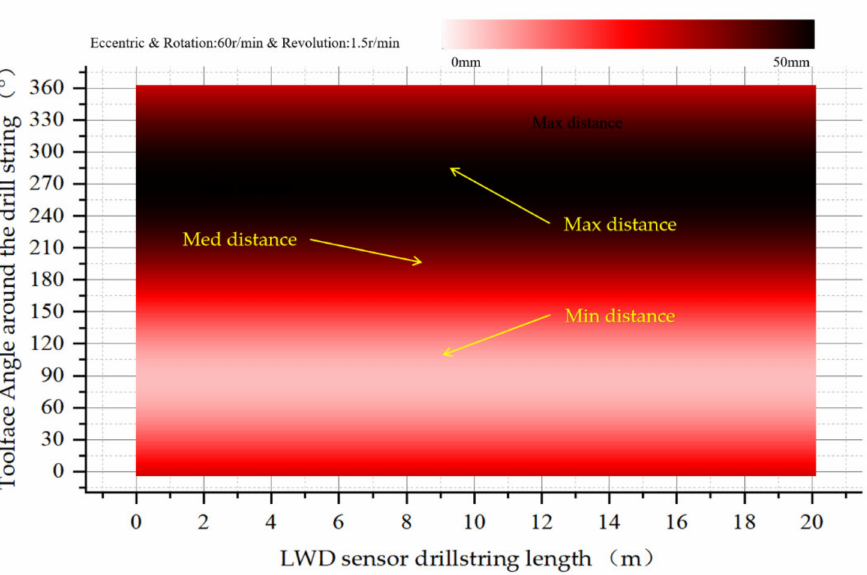
Figure 9. Eccentricity distance distribution along the surface of the drill collar during eccentric rotation. The simulation data are arranged and expanded in order. The angle interval is 2 ◦ and the depth interval is 50 mm. The first 2000 data obtained are shown in the following Figure 10.